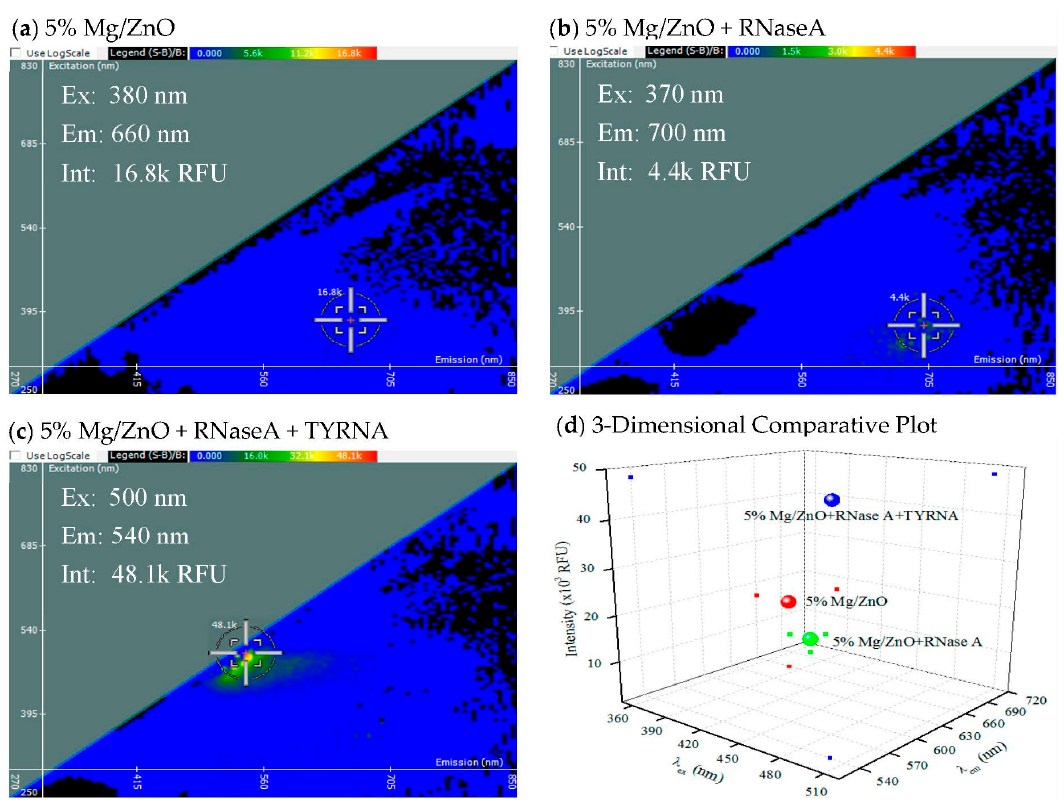
Figure 3. 2-D FDS of ( a ) 5% magnesium with 95% zinc oxide; ( b ) RNase A bound to 5% Mg/ZnO; and ( c ) torula yeast RNA and RNase A bound to 5% Mg/ZnO; ( d ) Three-dimensional comparative plot of the three 5% Mg/ZnO RNase A interactions.